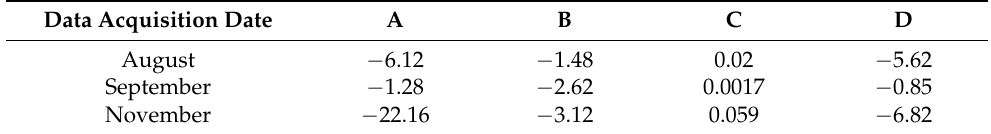
Table 2. Calibrated values of WCM